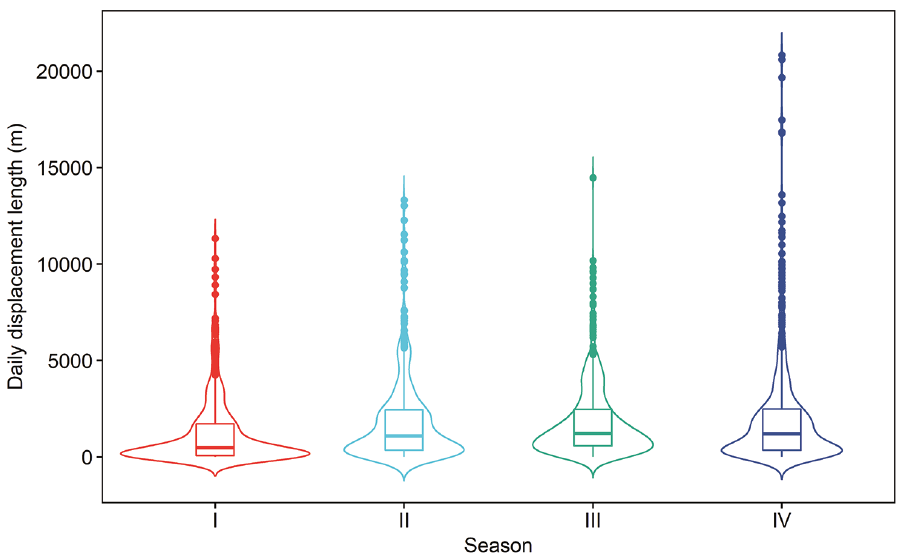
Figure 6. Seasonal variation of the mean daily displacement length of brown bear in Eastern Romanian Carpathians and Subcarpathians : I – Winter sleep ; II – Den exit and reproduction ; III – Forest fruits; IV – Hyperphagia. (Horizontal line = median value, box = interquartile range, the vertical width = density of the data within a season, points = outliers).